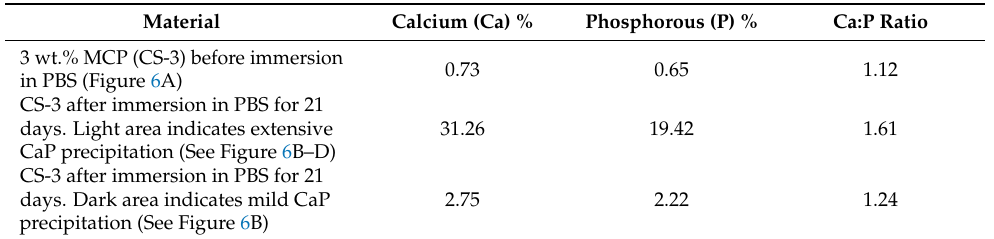
Figure 6. ( A ) SEM micrograph and EDS spectrum of the experimental composite with 3 wt.% MCP (CS ‐ 3) before immersion in PBS (600×); and ( B ) SEM micrograph and EDS of CS ‐ 3 after 21 days of storage in PBS. 6B shows two areas of calcium phosphate precipitation, a light area (box) and a dark area; ( C ) SEM image of the light boxed area of CS ‐ 3; ( D ) EDS of ( C ) indicates well ‐ developed calcium phosphate (CaP) crystals. Table 3. EDS analysis of calcium and phosphorous atom ratios observed on the surface of CS ‐ 3, before and after immersion in PBS for 21 days.